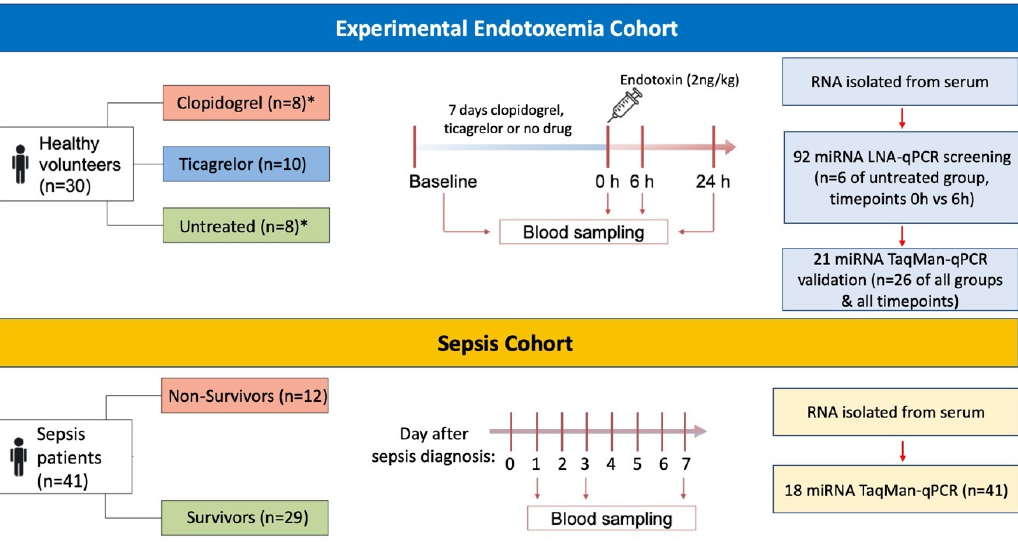
Figure 5. Schematic of experimental design. * Samples of 2 volunteers from the clopidogrel group and from the untreated group had to be excluded due to hemolysis.